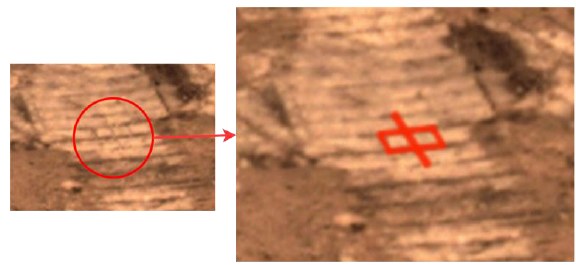
Figure 4. The rut of the Zhurong rover with Chinese word “ 中 ”.